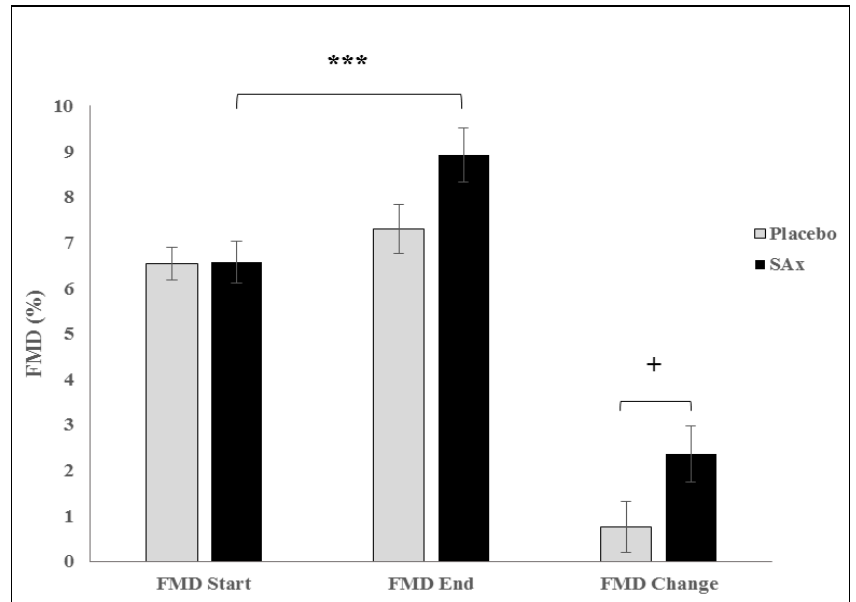
Figure 2 . Endothelial Function (FMD), which is a predictor of future cardiovascular events in symptomatic and asymptomatic subjects, significantly increased following SAx (Oral Supplementation with HT and PC) treatment (black color) in apparently healthy subjects (*** p < 0.001), and this improvement was significantly different compared to that observed following the placebo (grey) (+ p < 0.05). Forty-five subjects had endothelial dysfunction. Data represent the adjusted means ( ± SD) from multivariate models. Table 4. Oxidative status at the start and end of the supplementation and placebo